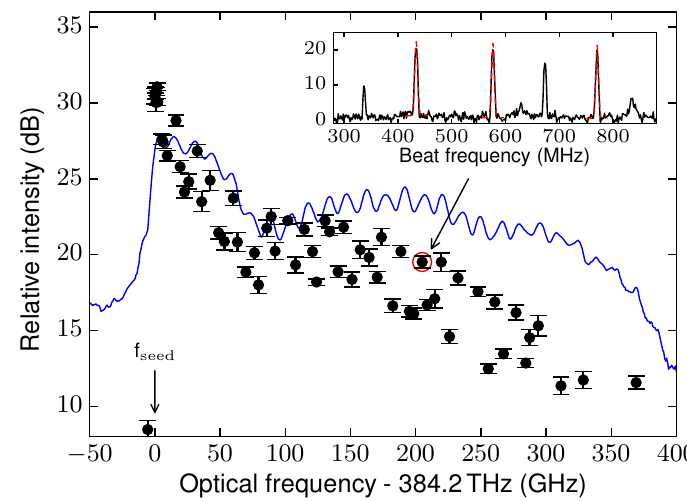
Figure 4: Spectrum of the seeded FSF laser. The intensity within a few GHz bandwidth is given relative to an arbitrary reference value. The blue trace stems from the grating spectrometer. Black circles show the height of the beat signal between the reference laser and FSF output, relative to the background. The inset shows the RF spectrum corresponding to the data point marked by an arrow and being